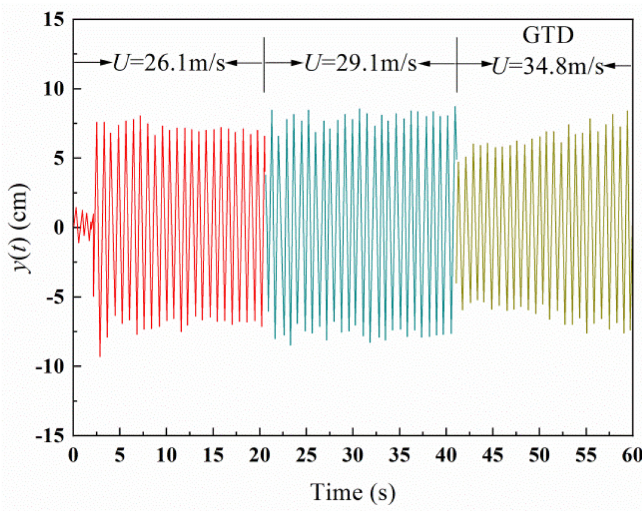
Figure 9. Soft flutter phenomenon of the wind-retaining plate section, − 5 ◦ angle of